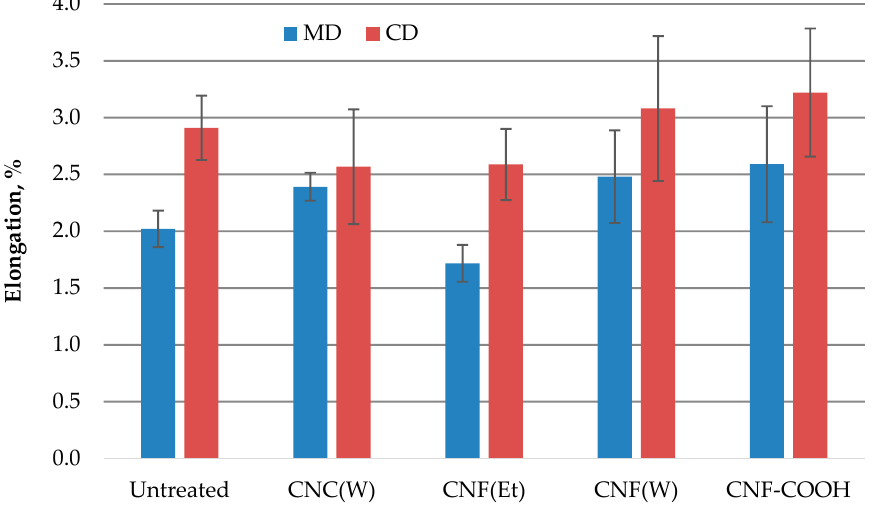
Figure 10. Elongation of treated WBP.